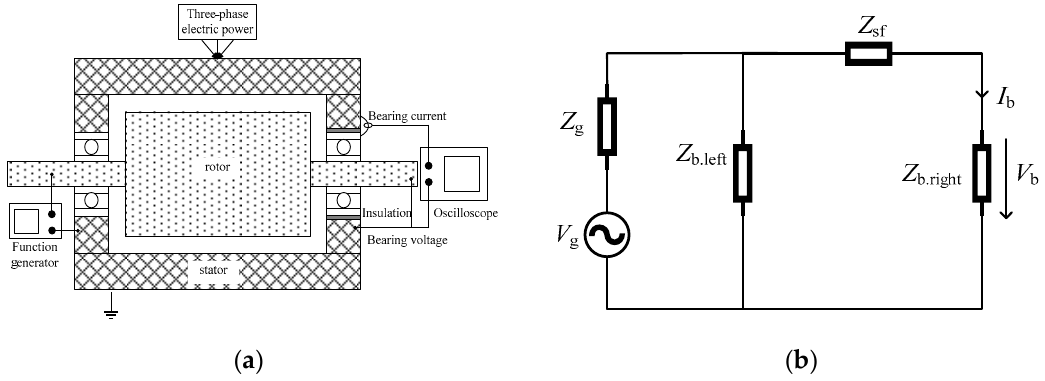
Figure 1. ( a ) The principle of the measurement; ( b ) The equivalent circuit of the measurement.